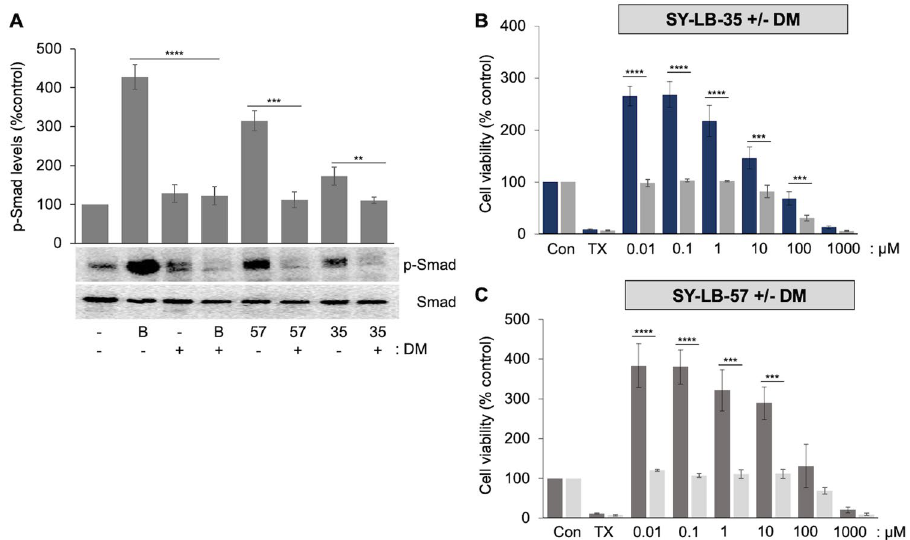
Figure 10. Increases in p-Smad by SY-LB-35 and SY-LB-57 is mediated by type I BMP receptor activity. ( A ) Western blot analysis using anti-p-Smad and anti-total Smad antibodies of serum-starved C2C12 whole cell lysates stimulated with BMP2 (50 ng/mL) as a positive control and 1 µM SY-LB-35 or SY-LB-57 in presence or absence of an inhibitor of type I BMP receptor activity, Dorsomorphin (DM; 10 µM), for 30 min. Pretreatment of C2C12 cells with DM for 1 h inhibited increases in Smad phosphorylation stimulated by BMP2 (DM(−) 428% versus DM(+) 122%, **** p < 0.0005), SY-LB-35 (DM(−) 315% versus DM(+) 112%, *** p < 0.001) and SY-LB-57 (DM(−) 172% versus DM(+) 111%, ** p < 0.01). The level of p-Smad was normalized to Smad levels. Data are expressed as mean ± SEM (n = 3). The original, uncropped blots are presented in Supplemental Fig. S11. ( B , C ). C2C12 cells were seeded in a 96-well plate, starved for 16 h, and stimulated with SY-LB-35 ( B ) or SY-LB-57 ( C ) (0.01–1000 µM) in presence or absence of DM (10 µM) for 24 h. Triton X-100 (125 µM) was used as negative control. DM blocked all increases in cell viability induced by SY-LB-35 (0.01 µM: DM(−) 266% versus DM(+) 98%; 0.1 µM: DM(−) 269% versus DM(+) 103%; 1 µM: DM(−) 218% versus DM(+) 102%, **** p < 0.0005; 10 µM: DM(−) 147% versus DM(+) 82%; 100 µM: DM(−) 69% versus DM(+) 30%, *** p < 0.001) and SY-LB- 57 (0.01 µM: DM(−) 384% versus DM(+) 120%; 0.1 µM: DM(−) 380% versus DM(+) 107%, **** p <